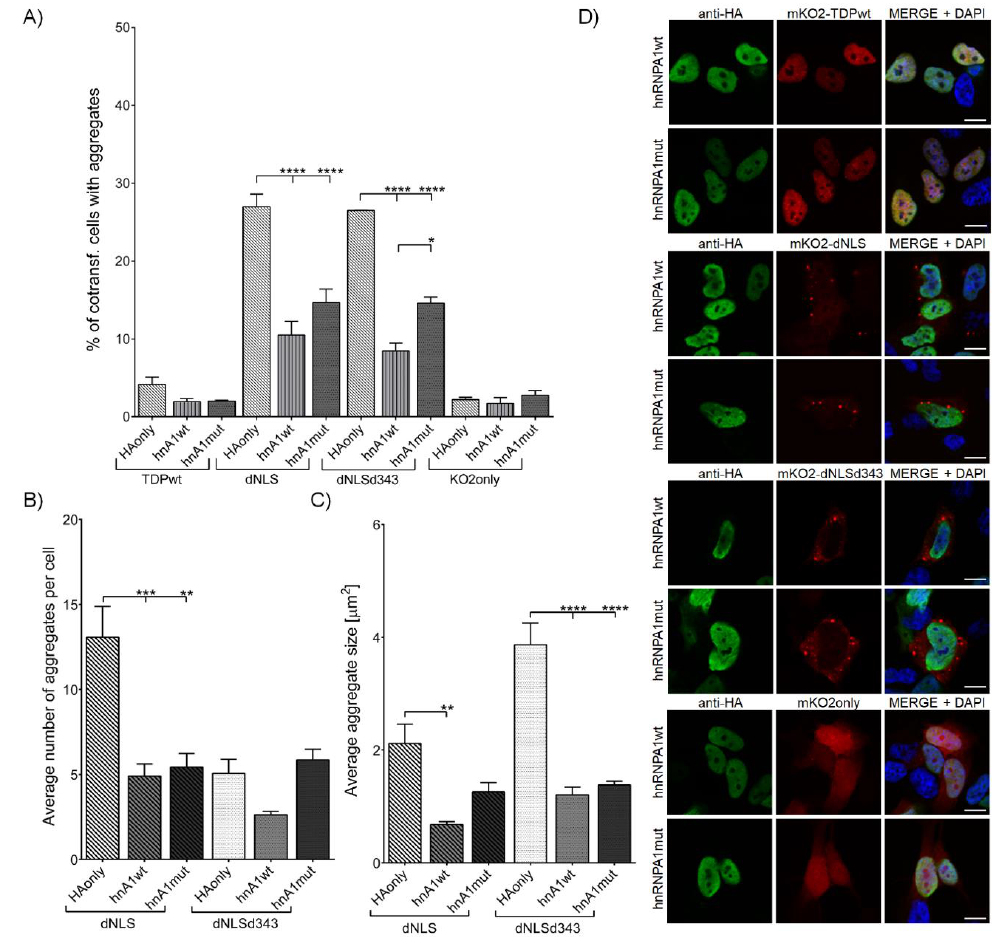
Figure 2. SH-SY5Y cells co-transfected with mKO2 constructs and wt or mut hnRNPA1. ( A ) Quantification of co-transfected cells harboring aggregates. ( B ) Average number of aggregates in an individual cell. ( C ) Average aggregate size. ( D ) SH-SY5Y cells co-transfected with mKO2 constructs and wt or mut hnRNPA1. Probed for HA-tag and counterstained with DAPI. Scale bars: 10